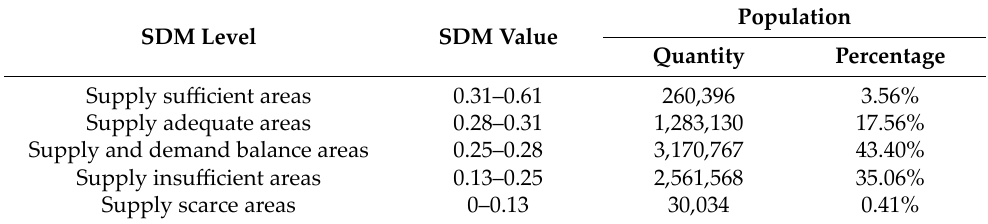
Table 7. Hierarchical statistics of SDM of comprehensive public health resources in research